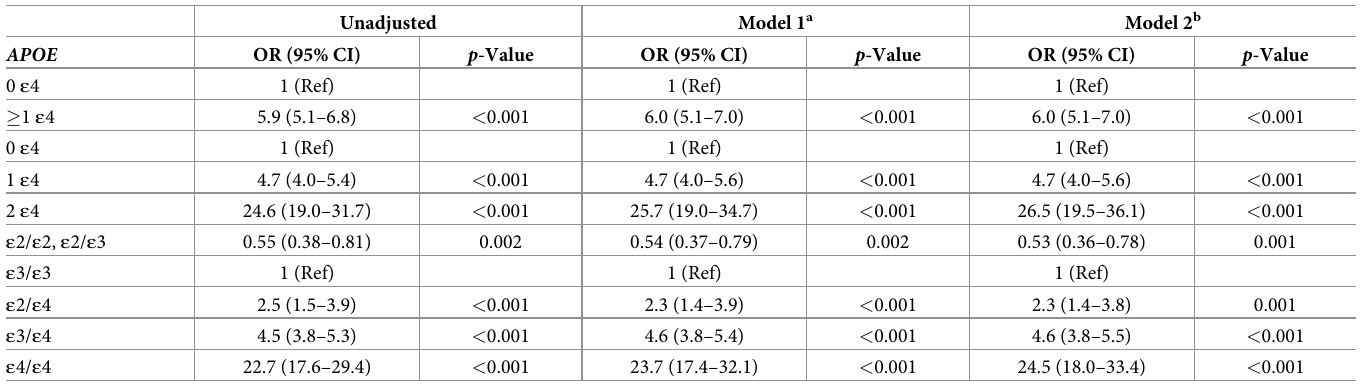
Table 3. The ORs of AD in CSF AD cases compared with population controls: multivariable logistic regression analysis. Unadjusted Model 1 a Model 2